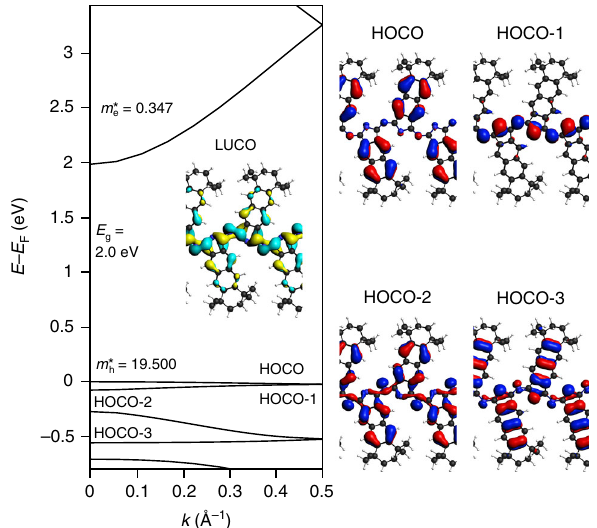
Fig. 5 Band structure and band gap ( E g , HSE06) of polycyanine chains. The crystal orbitals at the Γ -point (LUCO/HOCO: lowest unoccupied / highest occupied crystal orbital) are shown together with effective masses for electron ( m e *) and hole ( m h *)